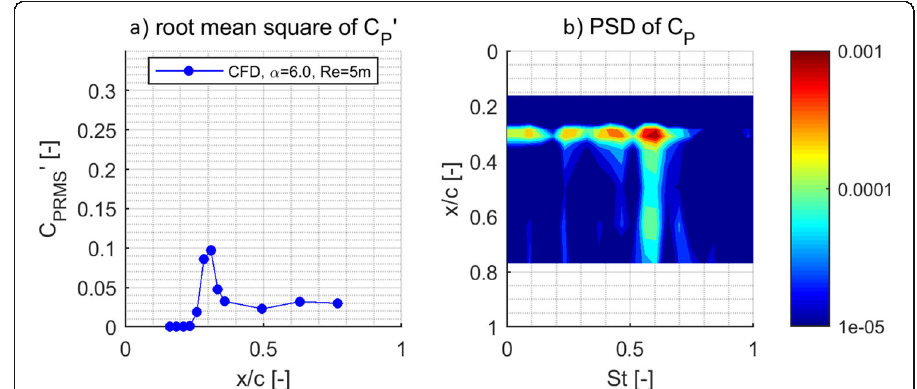
Fig. 8 Computed C PRMS ’ ( a ) and PSD ( b ) at η = 0.6 for α = 6°